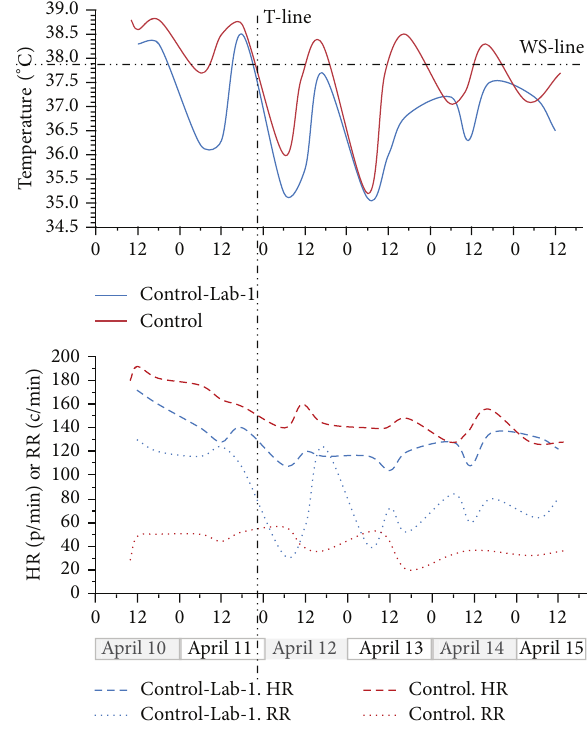
Figure 9: Comparative relationship between vital signs of two neonates nursed in the control ward and Lab-1. Baby “control” weighed2250 gandspentalltheindicated6daysinthecontrolward. Baby “control-Lab-1” weighed 2450 g, admitted in the control ward but transferred to Lab-1 just before midnight on 11 April. HR is heart rate (pulse/minute). RR is respiration rate (cycle/minute). T-Line is the time at which “baby control-Lab-1” was transferred. WS-Line is the critical temperature above which baby must be water-sponged as practiced at